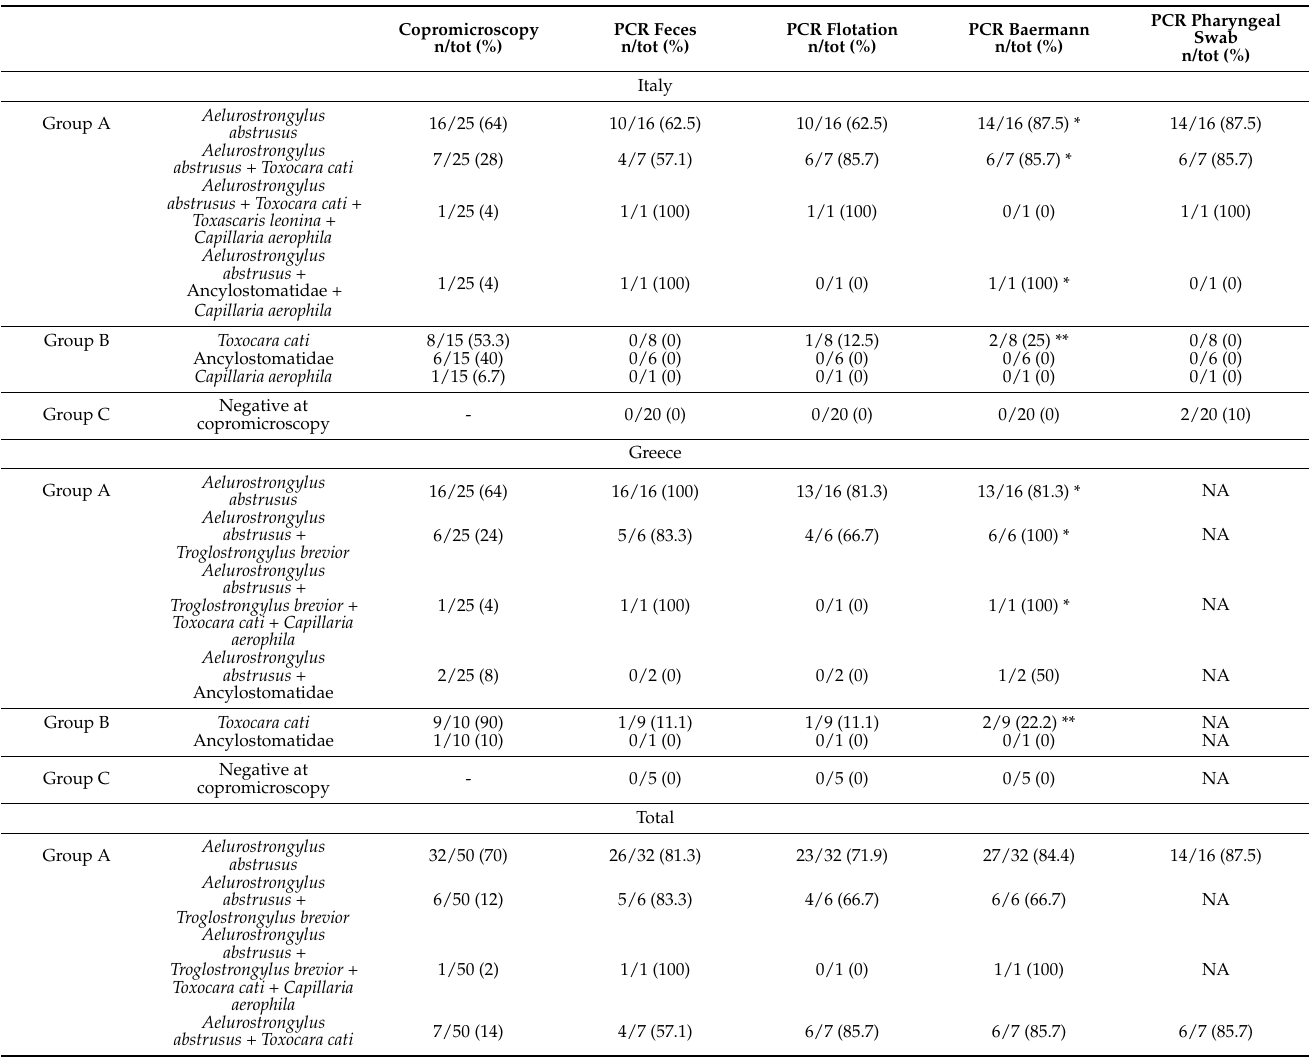
Table 2. Positivity in a nested PCR species-specific for Aelurostrongylus abstrusus of different fecal aliquots and pharyngeal swab collected from cats of the present study. The different combinations of co-infections are